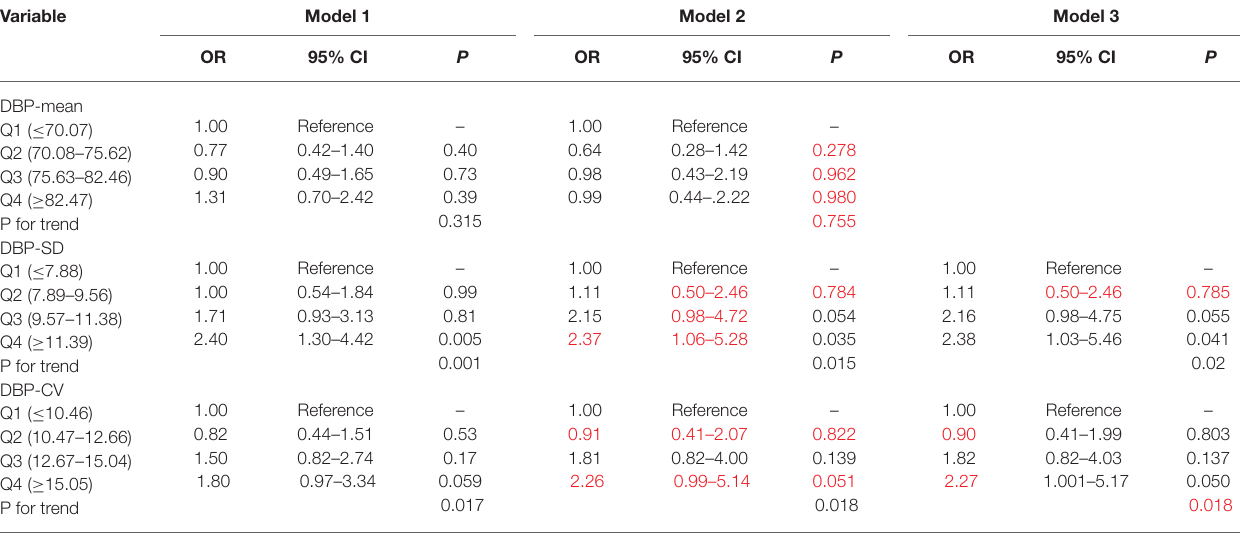
Model 1 was adjusted for age and gender; Model 2 was adjusted for Model 1 plus variables including, smoking, alcohol consumption, hypertension, AF, DM, CAD/HF, eGFR, WBC, TG, TC, HDL, NIHSS score, TOAST classification, Recanalized therapy, HT, Pulmonary infection and antihypertensive treatment; In Model 3, DBP-mean was included on the basis of Model 2.